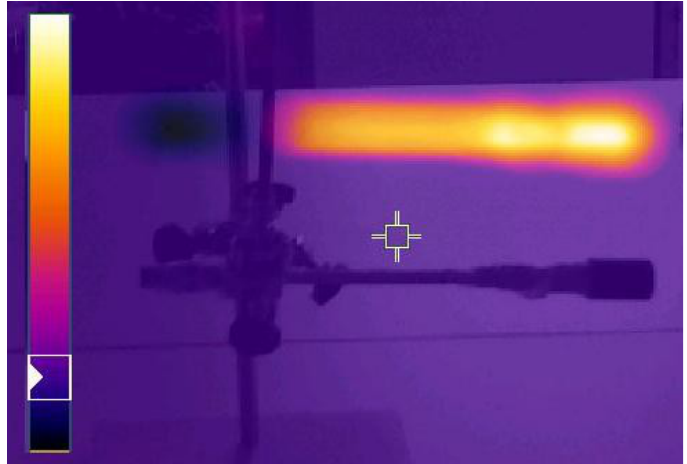
Figure 4. Thermal photography of the vortex tube operating with a cold fraction y =